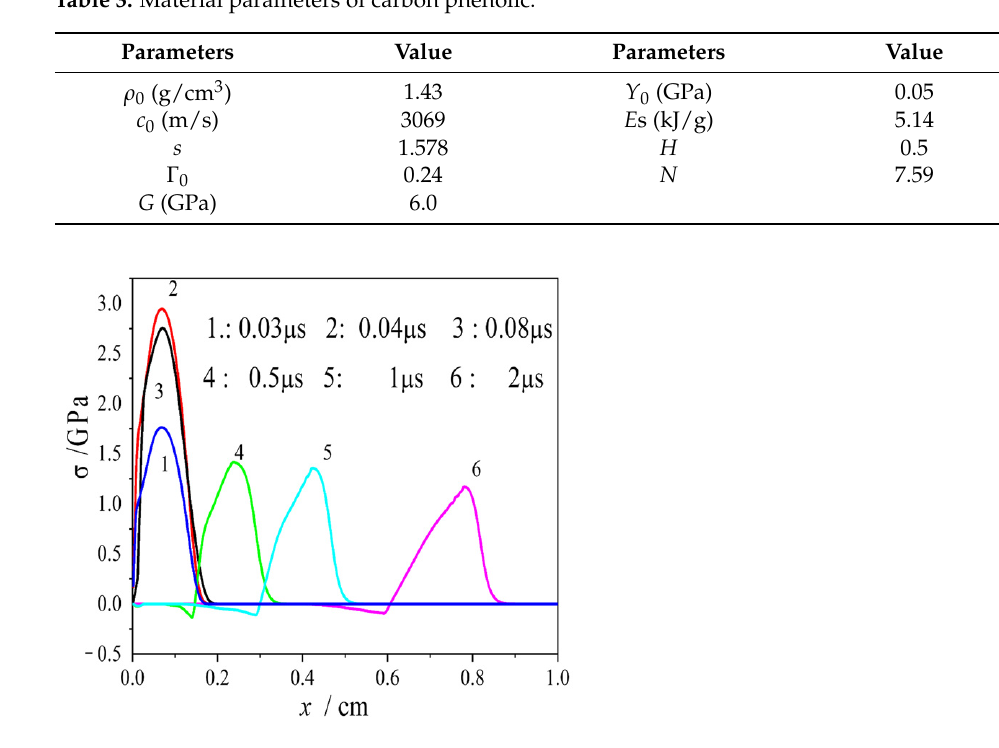
Figure 13. The s patial waveform of the thermal shock wave in carbon phenolic. Figure 13. The spatial waveform of the thermal shock wave in carbon phenolic.